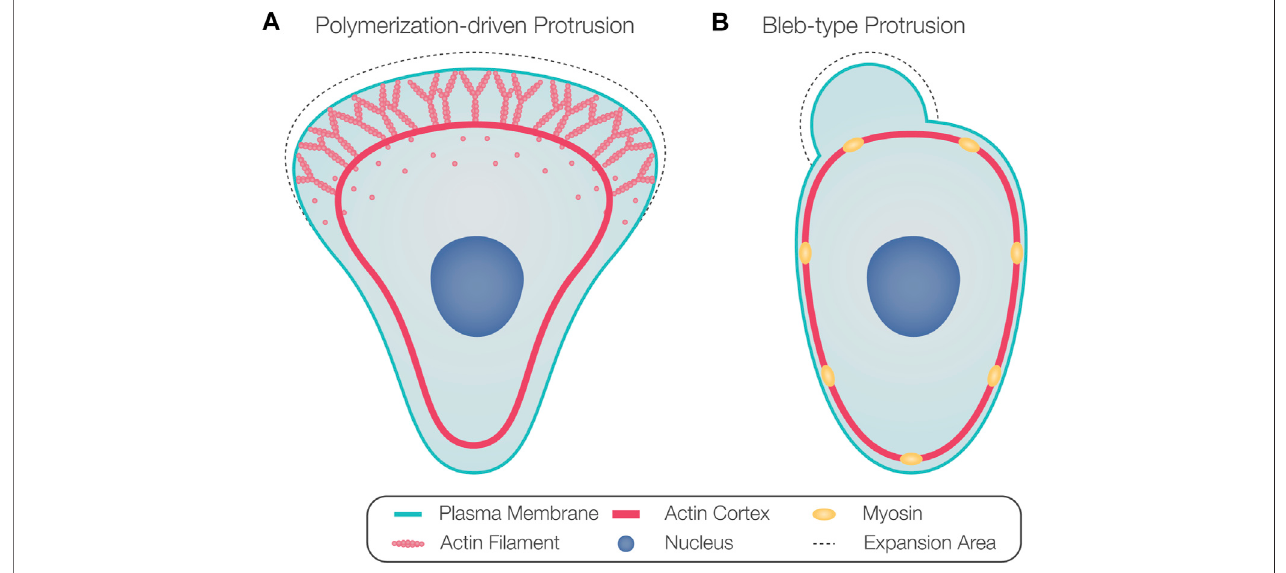
FIGURE1| Protrusionformationmechanisms. (A) Arraysofpolymerizingactin fi lamentspushingagainsttheplasmamembranegenerateforcetodrivemembrane protrusion forward. (B) Actomyosin contraction generates hydrostatic pressure that powers the in fl ation of a spherical membrane bleb.